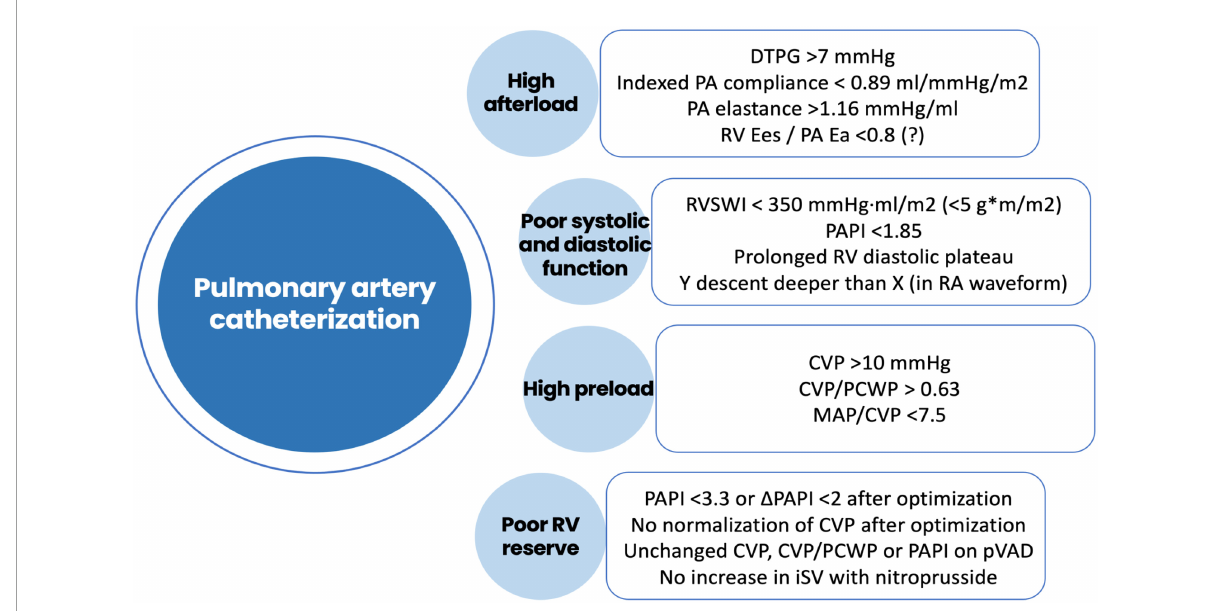
FIGURE4 Risk factors for right ventricular failure after LVAD implantation obtained using pulmonary artery catheterization. DTPG, diastolic transpulmonary gradient; PA, pulmonary artery; Ees, end-systolic elastance; Ea, arterial elastance; RVSWI, right ventricular stroke work index; RV, right ventricle; RA, right atrium; CVP, central venous pressure; PCWP, pre-capillary wedge pressure; MAP, mean arterial pressure; PAPI, pulmonary artery pulsatility index; pVAD, percutaneous ventricular assist device; iSV, indexed stroke volume.